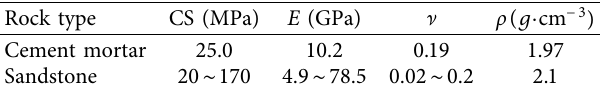
is the internal confining stress, 1